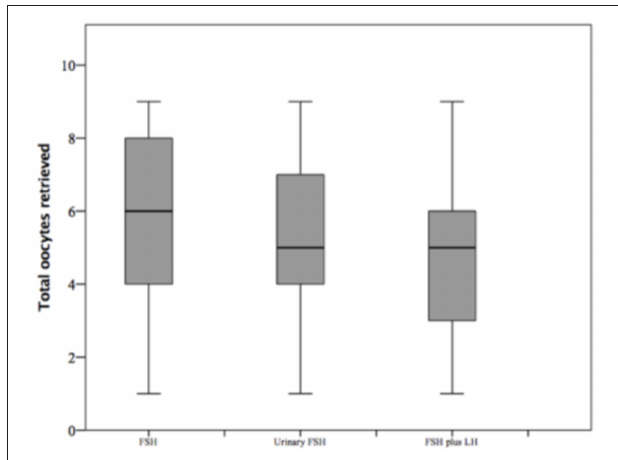
FIGURE 6 | Retrieved oocytes among groups of patients, divided according to gonadotropins regimen